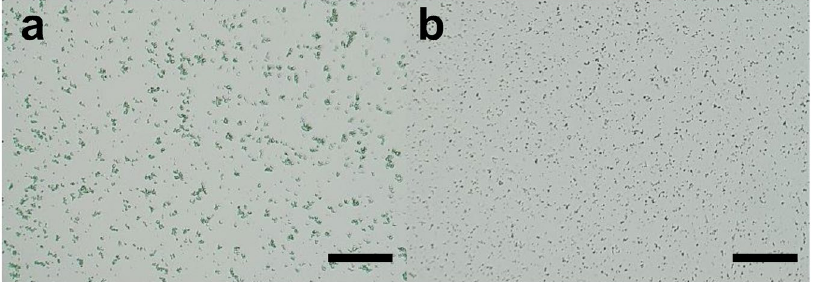
Figure 1. Proteinase K crystals used for SFX measurements, ( a ) sized 2 μ m × 2 μ m and ( b ) 0.8 μ m × 0.8 μ m. Scale bars represent 100 μ